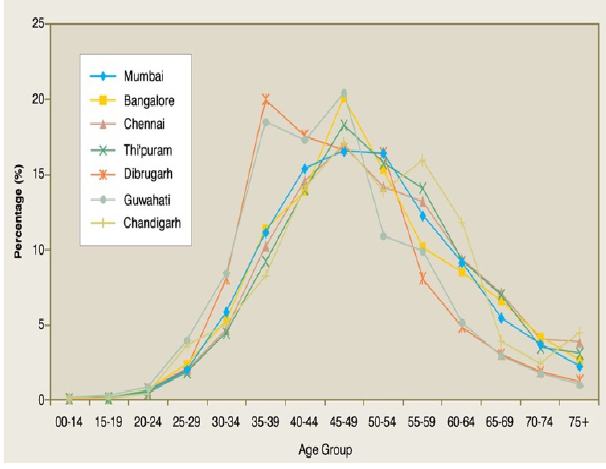
Figure 2. 5-year age distribution trends for different NCRP (2010-2012) –Female Breast (ICD-10: C50)